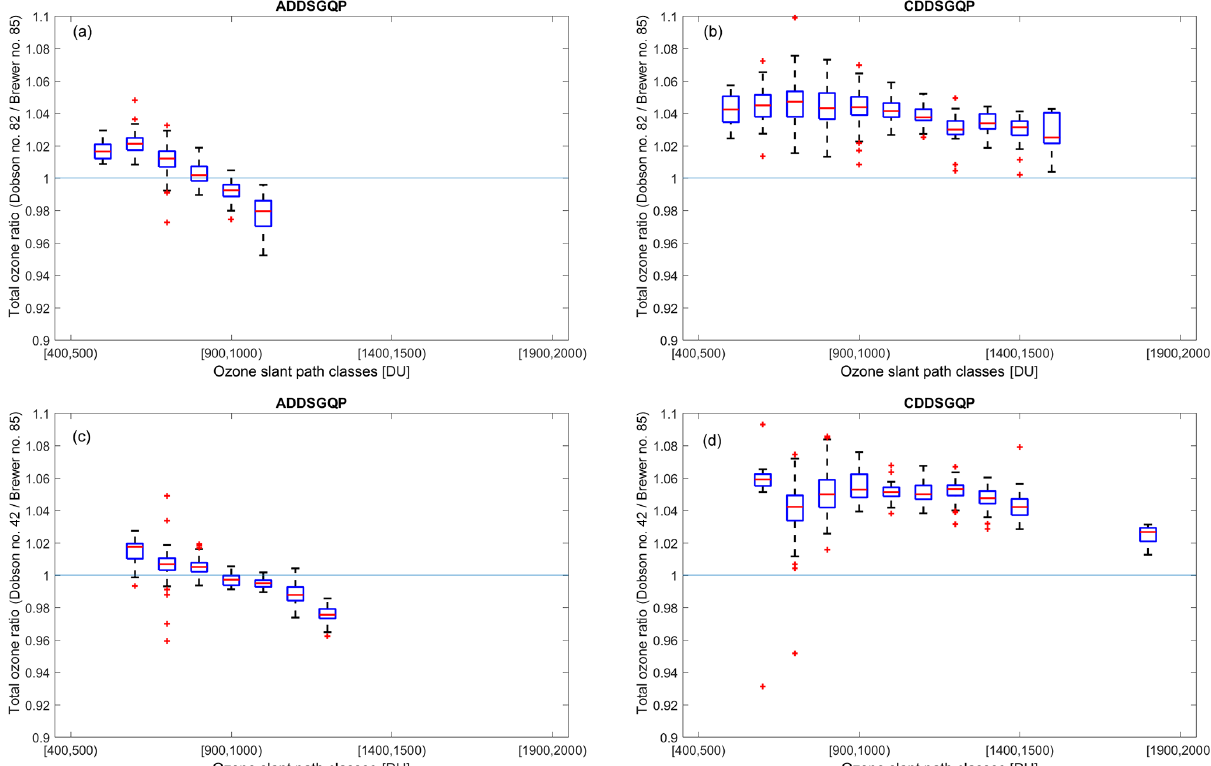
Figure 11. The ratio of quasi-simultaneous direct sun observations (within 5min) by (a, b) Dobsons no. 82 and (c, d) no. 42, AD and CD wavelengths to data from double Brewer no. 085 at the South Pole for total ozone values larger than 220DU. For each box, the central red line is the median, the edges of the box are the 25th and 75th percentiles, the whiskers extend to the most extreme data points not considered outliers, and outliers are plotted individually. In each bin the values with differences larger than 3 standard deviations from the mean of the bin have been removed from the calculation. Note that only bins with more than six simultaneous measurements are depicted. The title of plots shows the type of measurements. ADDSGQP: AD direct sun measurement using a ground quartz plate, and CDDSGQP: CD direct sun measurement using a ground quartz